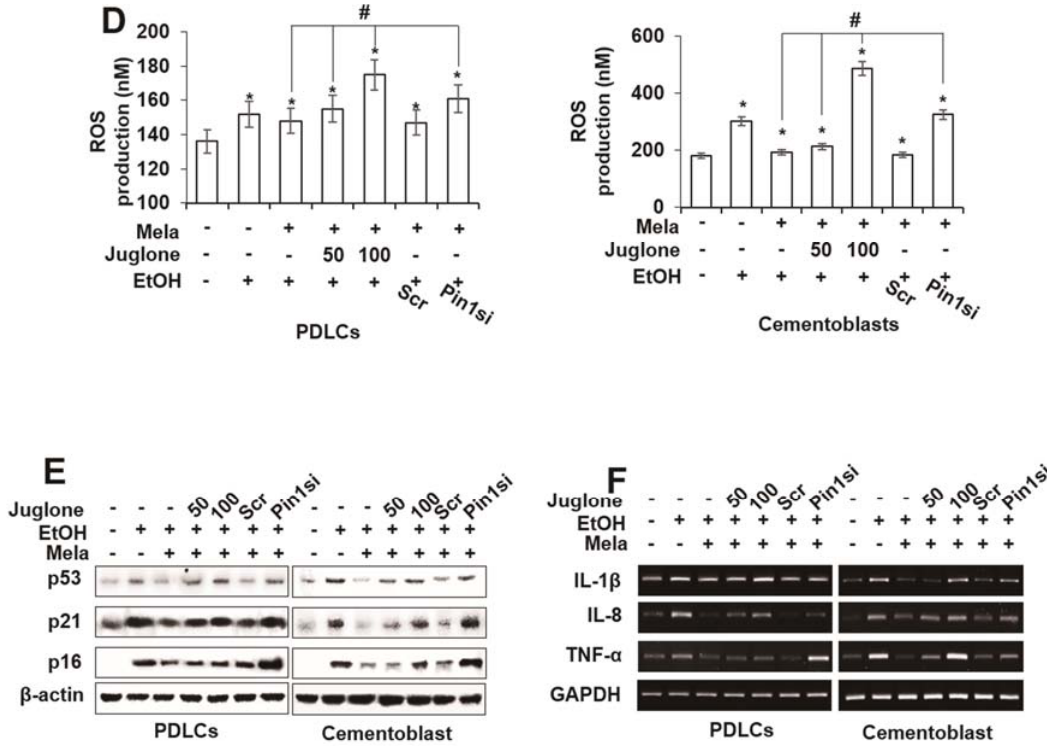
Figure 5. Involvement of PIN1 pathway on effects of melatonin in EtOH-induced cellular senescence of PDLCs and cementoblasts. Cells are pretreated with juglone or PIN1 siRNA and then incubated with melatonin (100 μ M) and EtOH (25 mM) for 3 days ( A – F ). mRNA and protein expression were accessed by Western blot and RT-PCR ( A , B , E , F ), respectively. Senescence was examined by β -gal activity ( C ), ROS production ( D , E ) and expression of senescence-associated proteins ( E ) and mRNAs ( F ). These data are representative of three independent experiments. *: statistically significant difference compared to the control groups ( p < 0.05). # : statistically significant difference in each group.